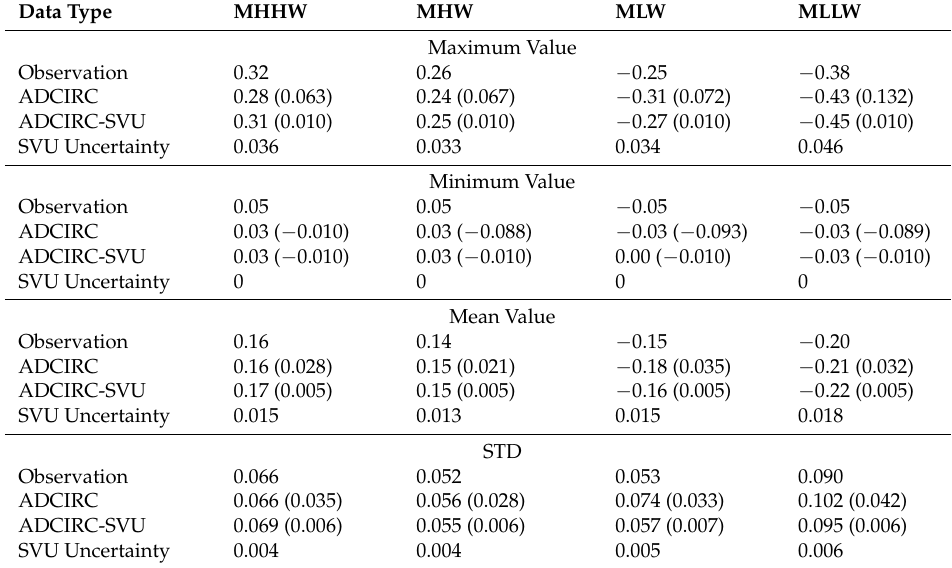
Table 1. Statistical values of observed and modeled tidal datums and the associated SVU spatially varying uncertainties (in meters). Model errors from observations are given in parentheses when applicable; note that errors do not necessarily correspond to the categorical value reported next to them (e.g., min, max, mean), but are instead the categorical error over the entire model domain. For example, the maximum model error (0.063) next to the maximum value of ADCIRC modeled MHHW (0.28) refers to the maximum model error of ADCIRC modeled MHHW in comparison with the observations at the 75 tide stations. Note also: Model errors refer to modeled tidal datums minus observed tidal datums; “Mean Value” of ADCIRC model errors refers to Mean (Abs(ADCIRC model error)); “Mean Value” of ADCIRC-SVU model errors refers to Mean (Abs(ADCIRC-SVU model error)); “STD” stands for Standard Deviation.